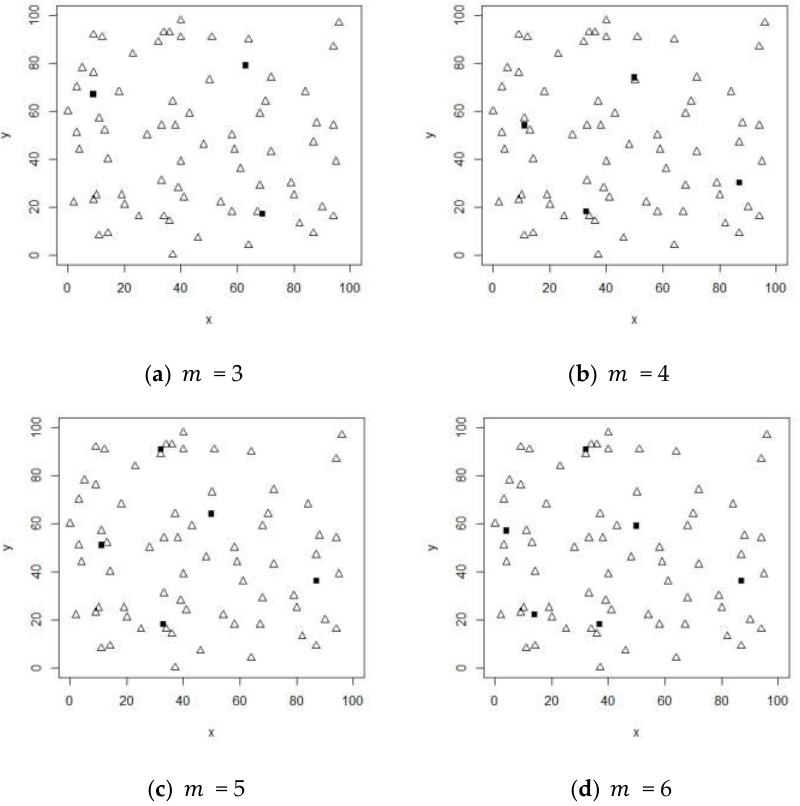
Figure 5. Globally optimal facility locations in the planning area for Instance 26. ( a ) m = 3; ( b ) m = 4; ( c ) m = 5; ( d ) m = 6.